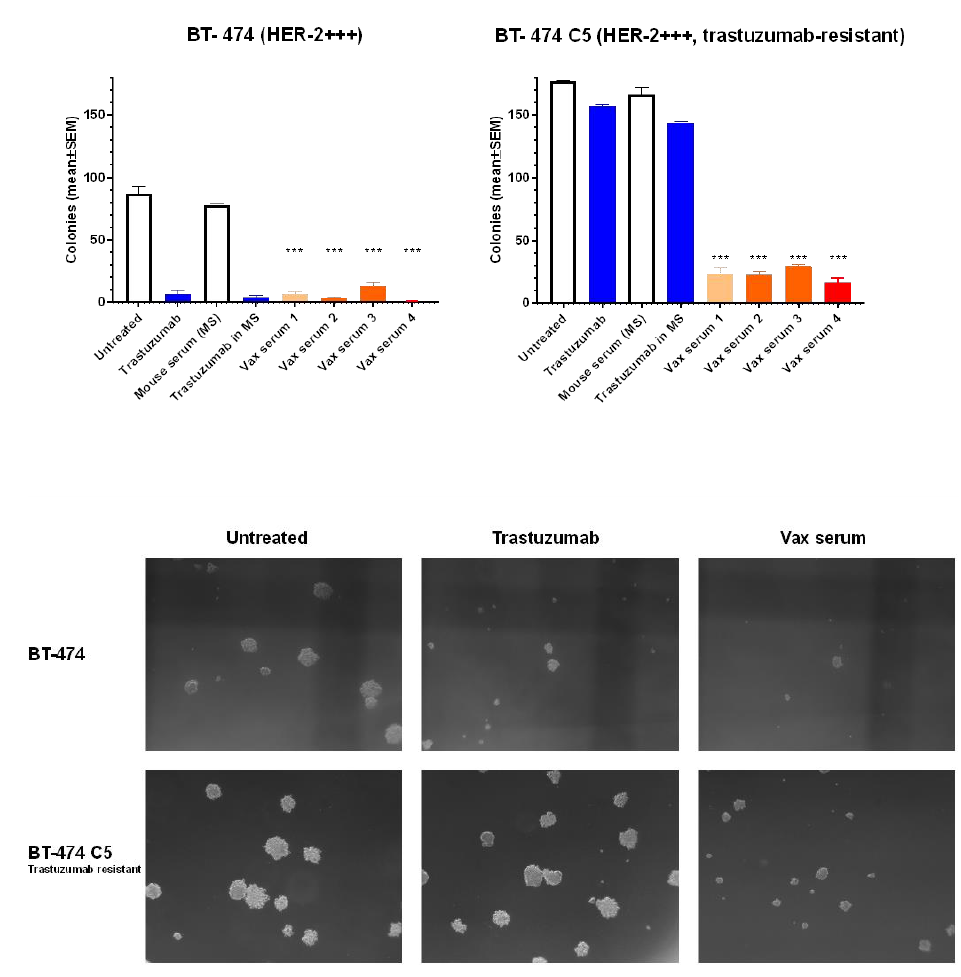
Figure 5. Inhibition of human breast cancer cell 3D agar colony growth by antibodies elicited by ES2B-C001 vaccinations. BT-474 is a HER-2+++ trastuzumab-sensitive cell line, and C5 is a trastuzumab-resistant BT-474 clone. Each bar represents the mean (and SEM) number of colonies larger than 90 µ m as counted in two independent cultures with the aid of a micrometer. Vax sera 1–4: sera of 4 previously unchallenged FVB mice vaccinated twice with ES2B-C001 (10–40 µ g/mouse i.m. with Montanide) were compared with a pool of naïve mouse sera (MS) as a negative control and benched-marked up against trastuzumab applied in a comparable concentration. *** p < 0.001 vs. MS; p < 0.05 at least vs. both MS and trastuzumab, Tukey’s test. Representative micrographs of live agar colonies were taken with an inverted microscope (dark-field, 25×).